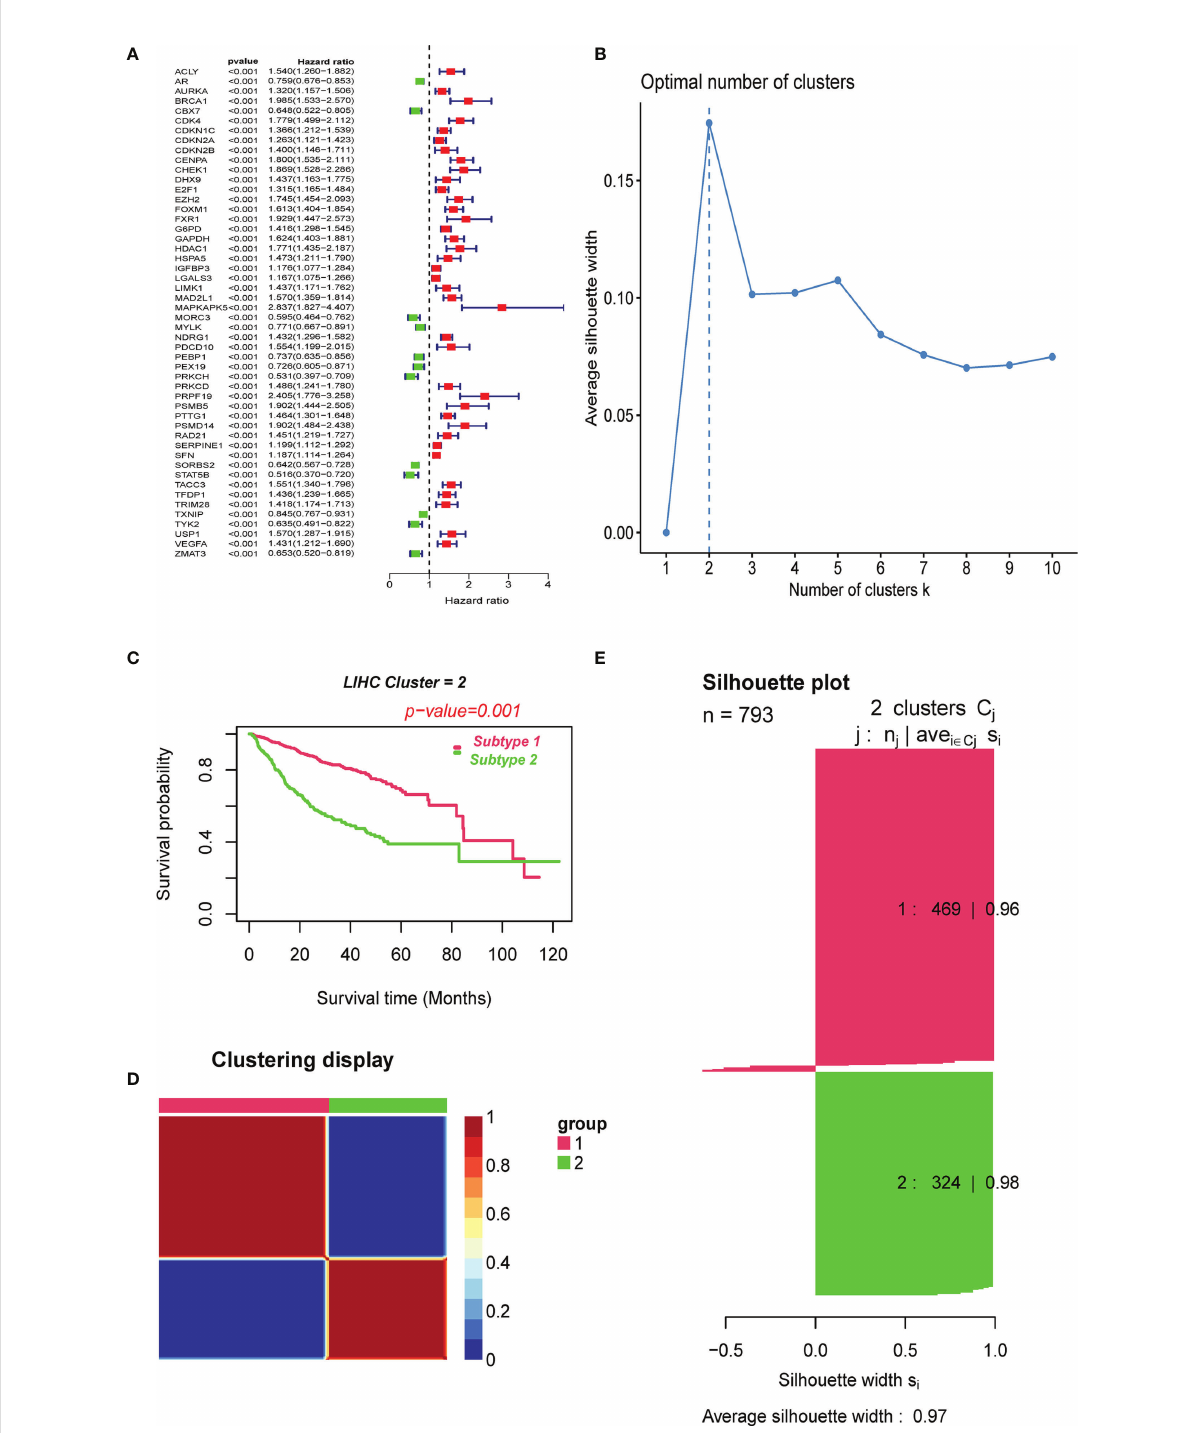
FIGURE 1 Clustering of cell senescence genes – based subtypes in combined meta-data cohorts using NMF algorithm. (A) Screening of prognostic CSRGs by univariate Cox regression analysis. (B) The optimal cluster number was determined to be two. (C) The log-rank test P-value for survival curve analysis of the patients in the two clusters. (D) The clustering heat map visualizes the degree of segmentation in sample clustering. (E) The average silhouette width represents the coherence of